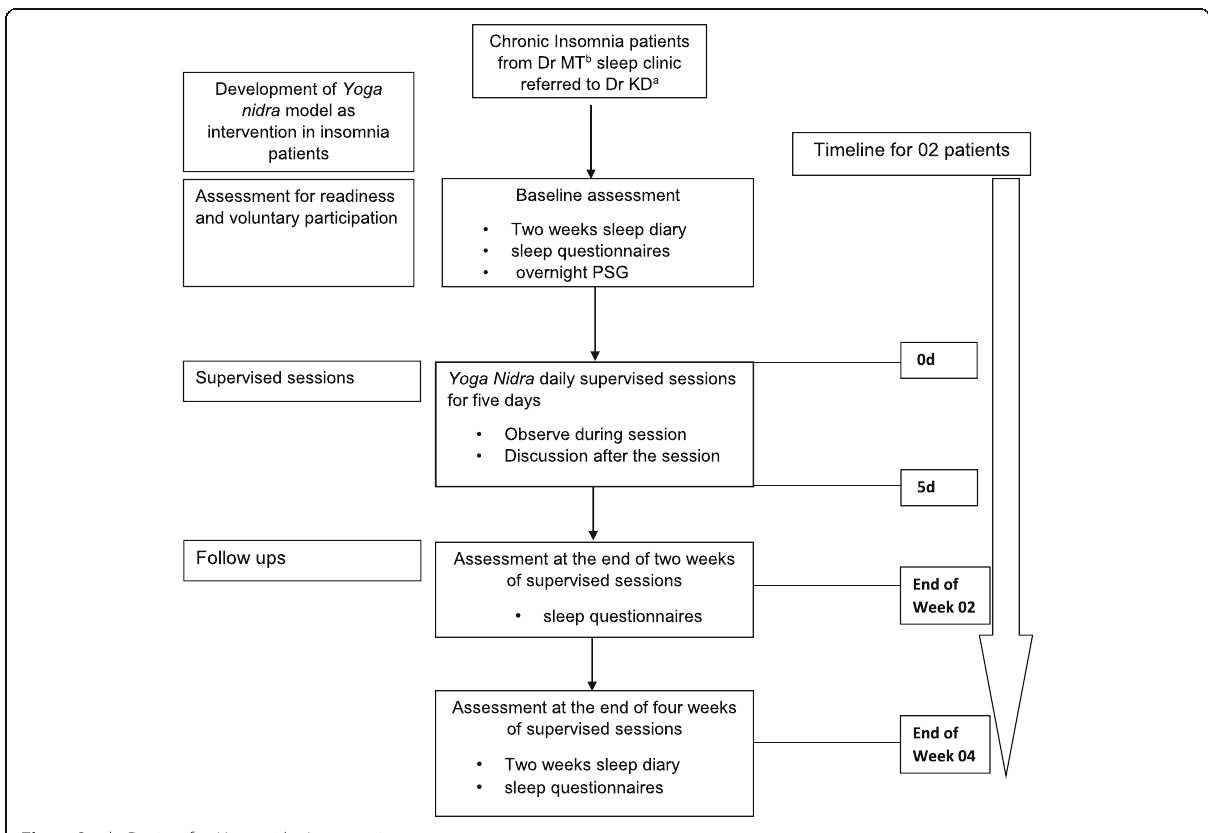
Fig. 1 Study Design for Yoga nidra